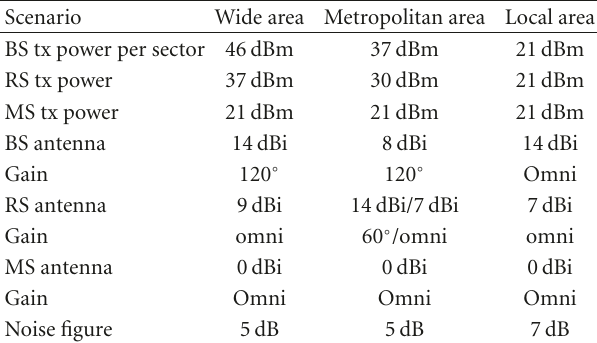
Table 4: Additional parameters for test